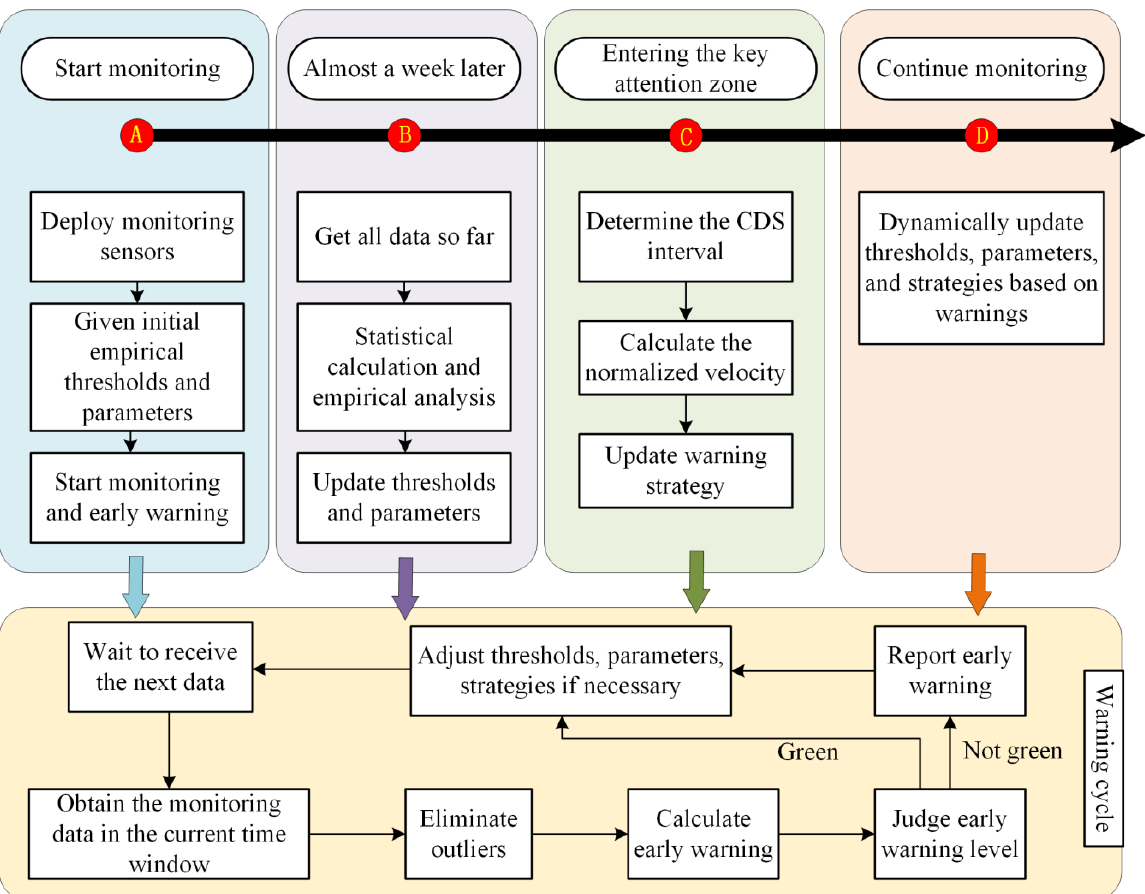
Figure 2. The flowchart of the hybrid early warning